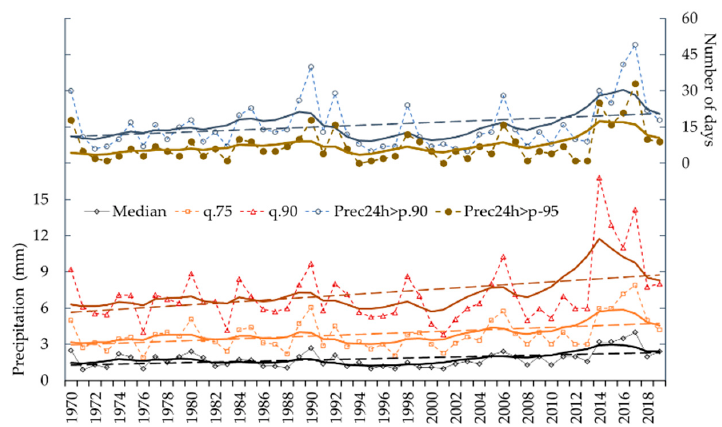
Figure 9. Annual variability (dashed curves) and decadal-like (solid curves) behavior of the median, the third quartile (0.75), the 0.90 percentile and the number of precipitation days ≥ the 0.90 and 0.95 percentiles.